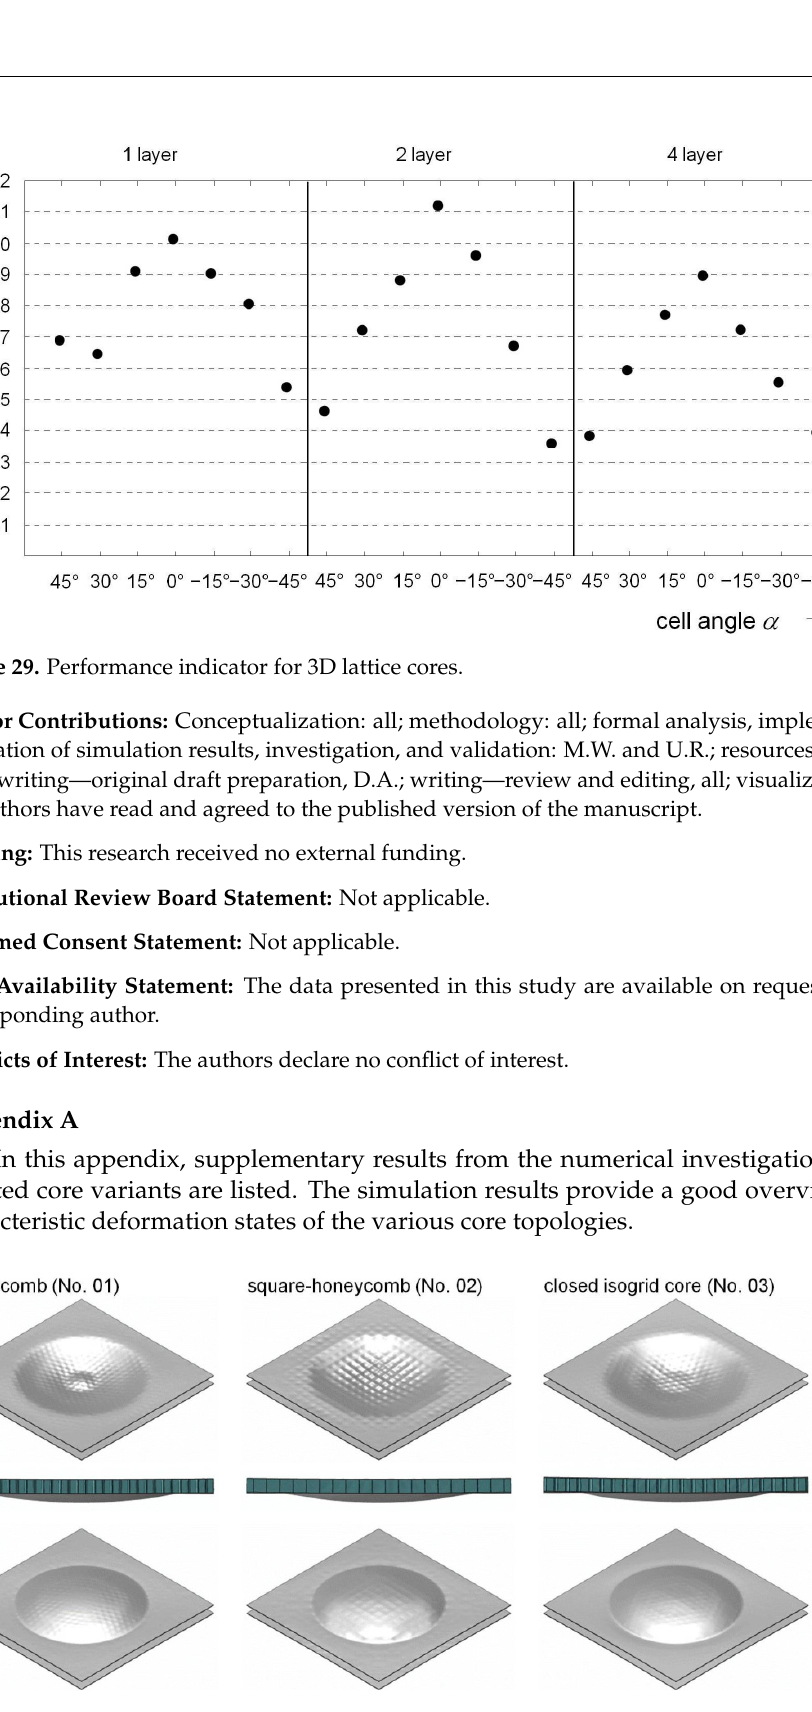
Figure A2. Deformation states of the top and bottom sides for honeycomb cores No. 04–07 subject ‐ ed to air ‐ blast loading (t = 0.6 ms).